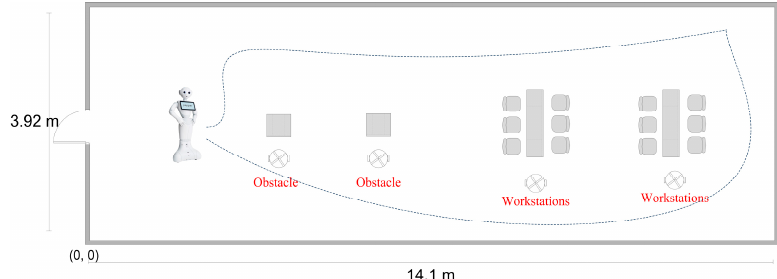
Figure 13. Pepper’s path in Area 1.